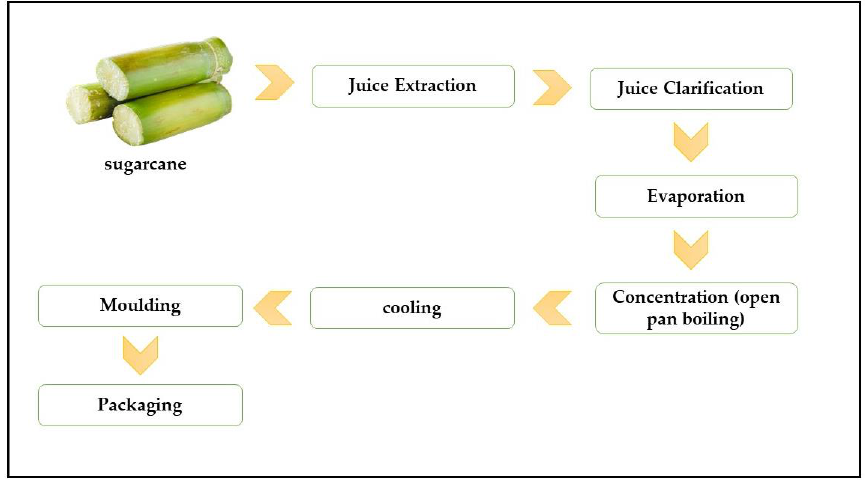
Figure 2. Production diagram of NCS. Table 5. Different NCS names in different countries [19].